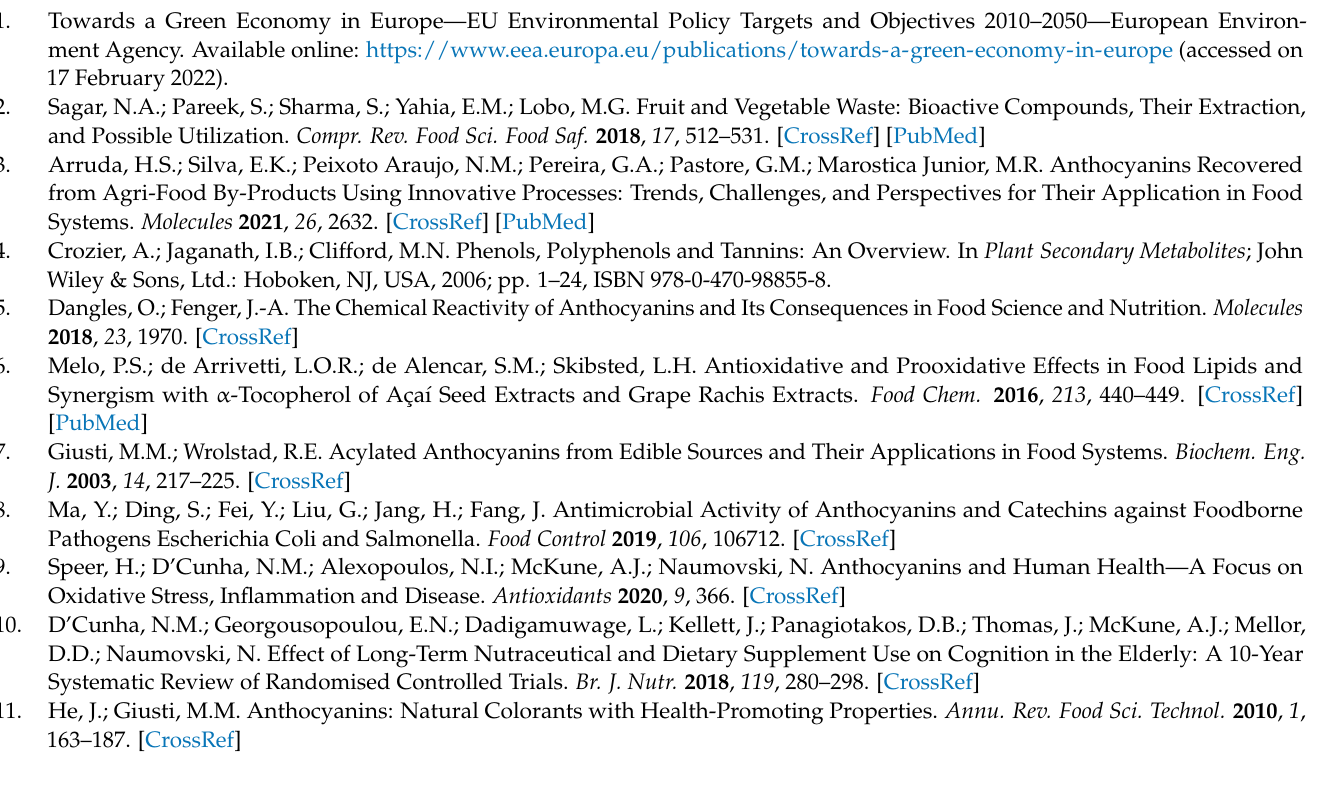
Table S1: Anthocyanin composition of the different plant sources considered in our survey with the substitute groups in the molecules, and analytical methods of detection